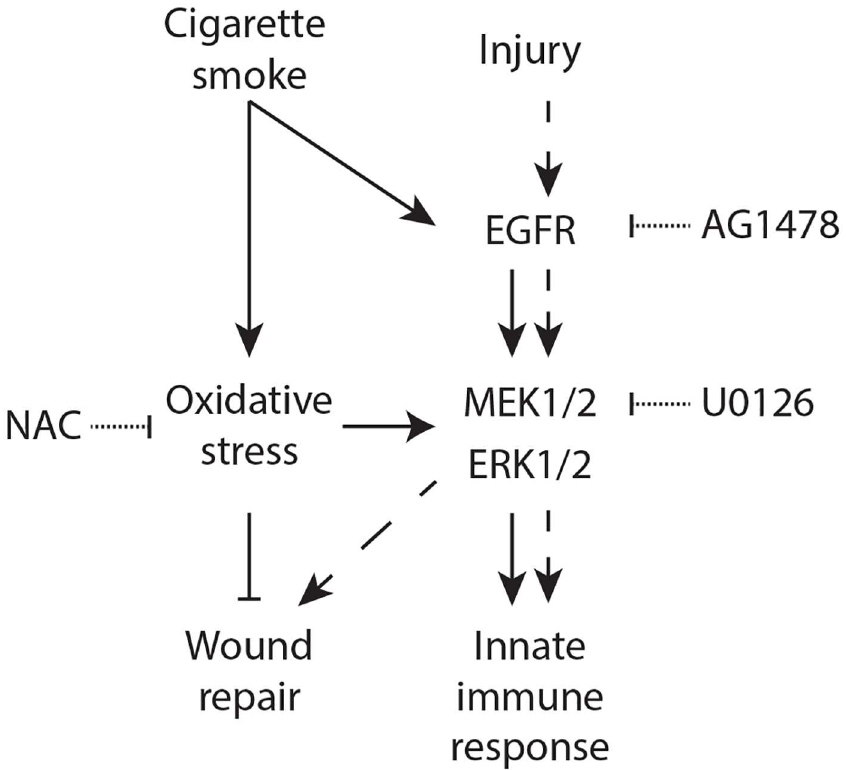
ERK1/2 via oxidative stress, which is independent of EGFR signaling.EGFR/ERK1/2-mediatedwound repair is suppressedby CS via oxidative stress. In contrast, activation of ERK1/2 due to a combinedeffect